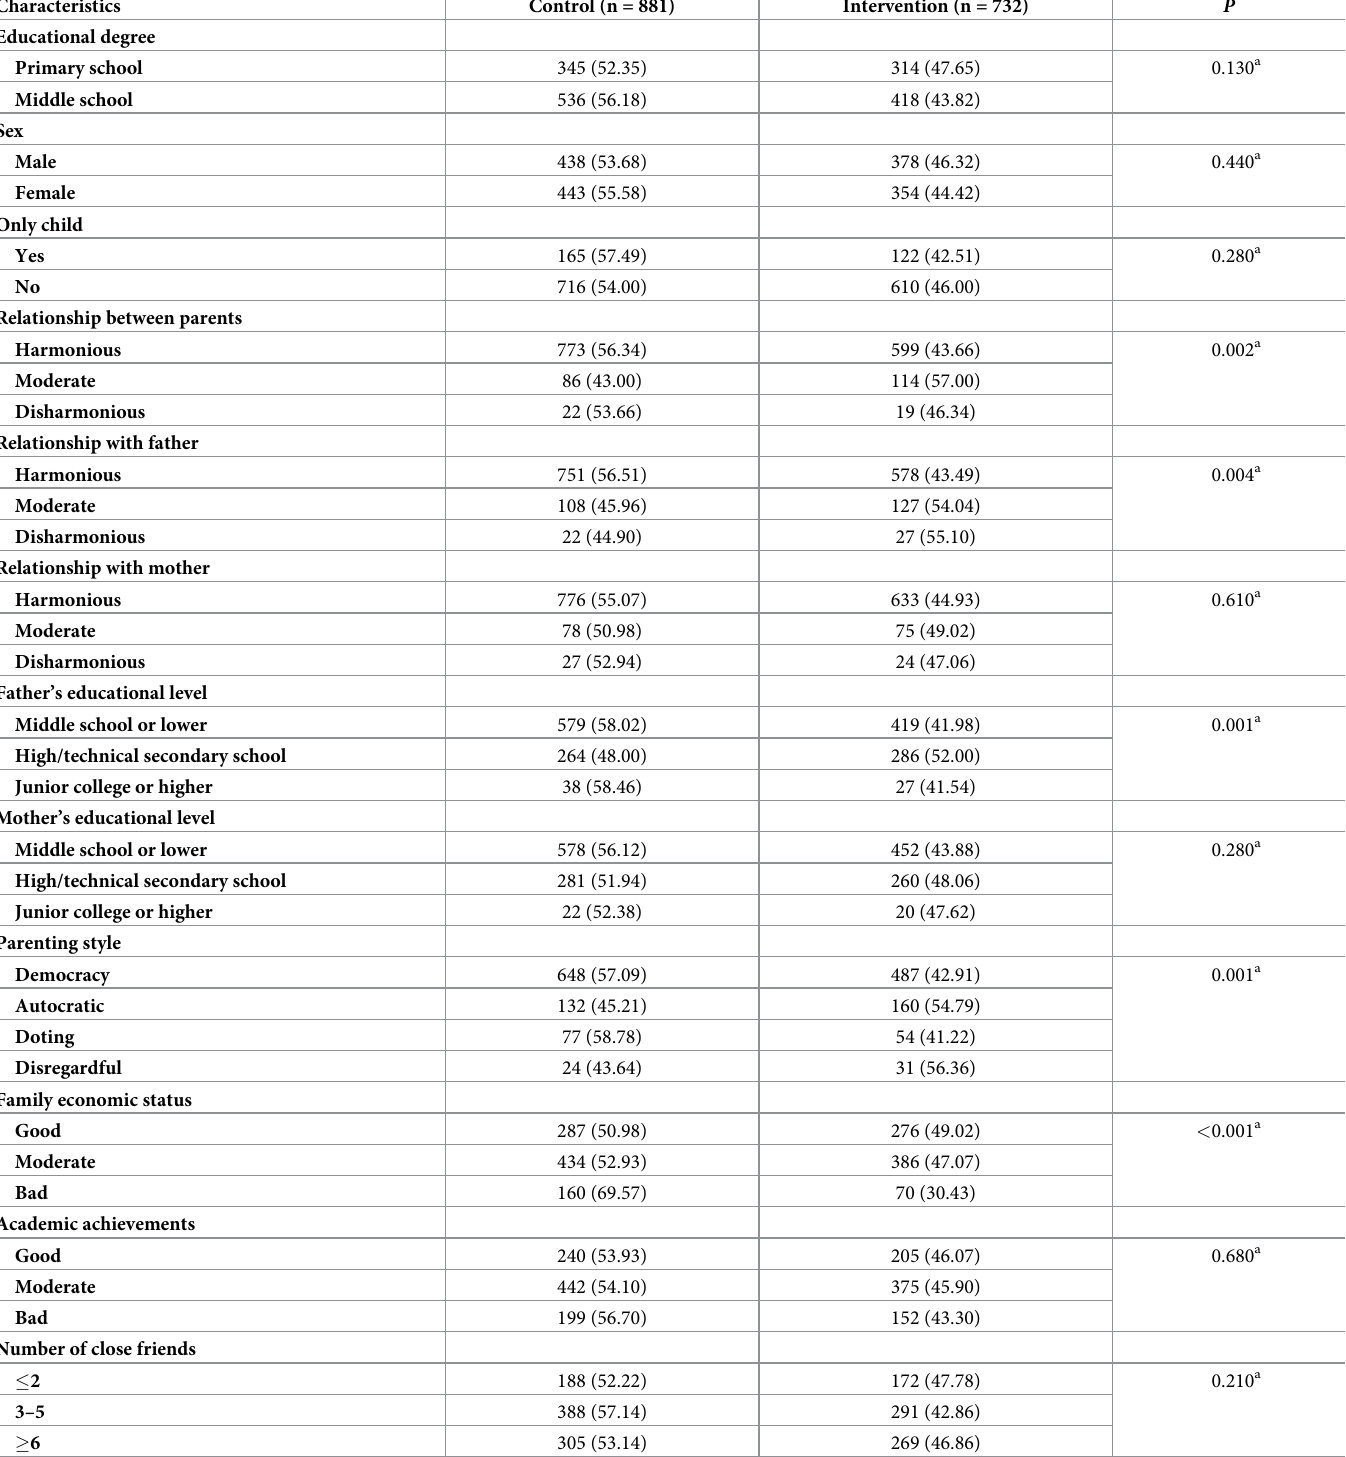
Table 1. The distribution of sociodemographic characteristics between intervention group and control group (n = 1,613).